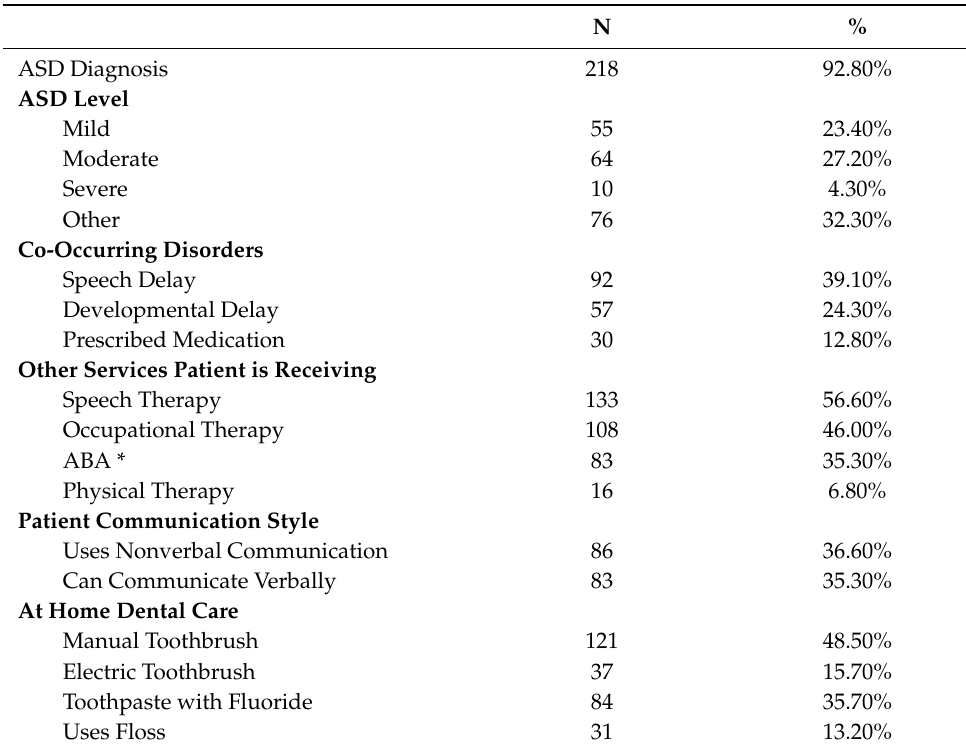
Table 2. Patient health characteristics.